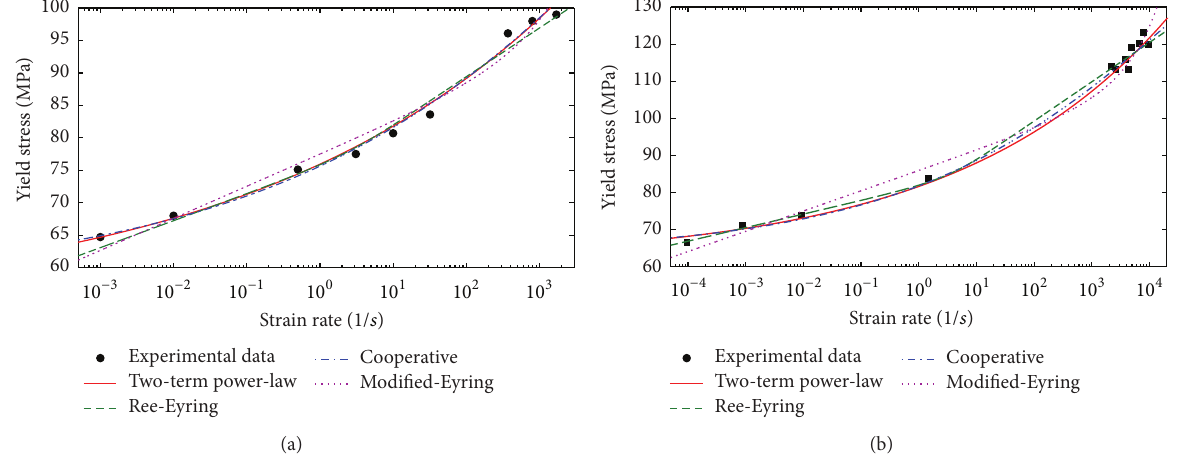
Figure 6: Comparison of the four equations: (a) tension and (b) compression.